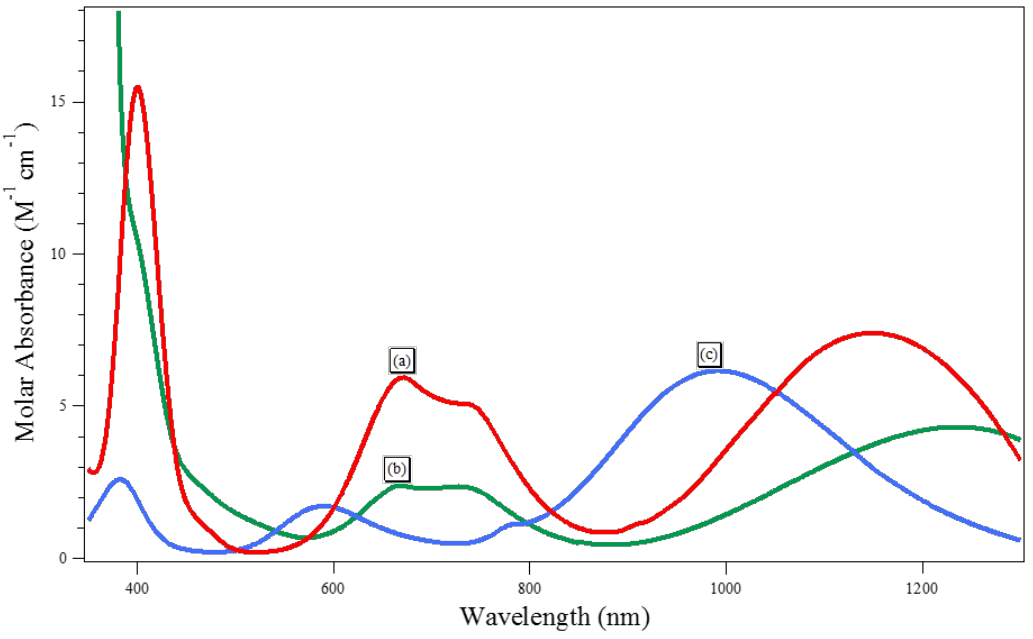
Figure 4. UV-Vis spectra of Ni(NO 3 ) 2 in ILs ( a ) BuNC 2 OC 4 -ClSal phase; ( b ) BuNC 2 OC 4 -Dca and ( c ) aqueous phase. C metal = 0.05 mol L −1 ; V w = 2 mL; m Il = 0.5 g; UV-vis spectra are recorded in ethylacetate for ionic liquid (IL) phase.